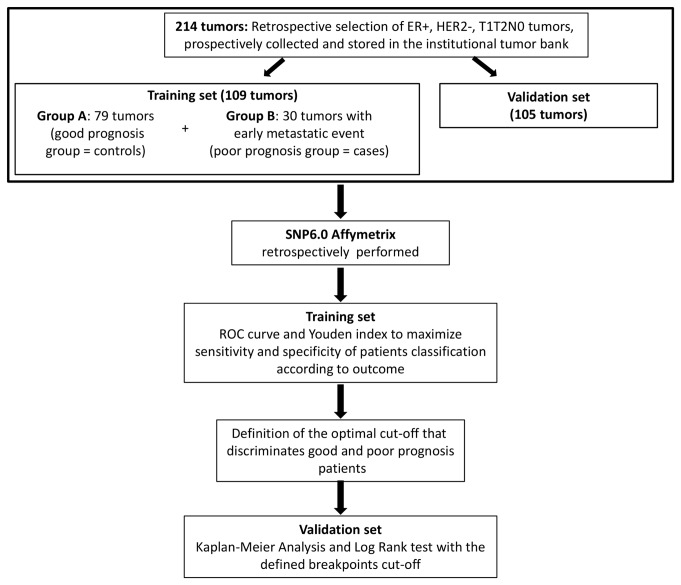
Flowshart of patients and tumor’s selection and design of the study.